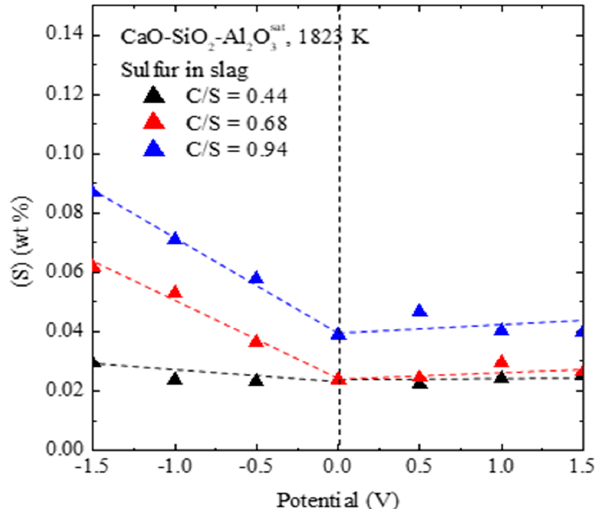
Figure 6. Effect of the electrical potential on residual sulfur concentration in the slag.